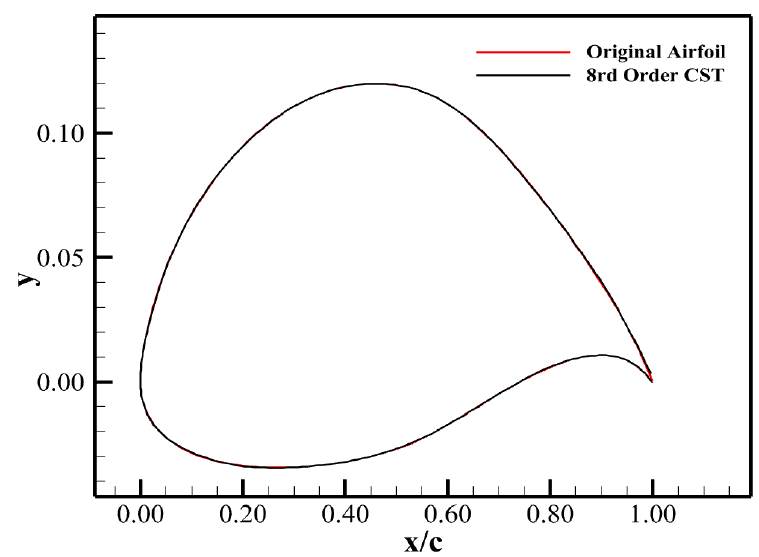
Figure 4. NLF-1015 airfoil fitting results of CST method.